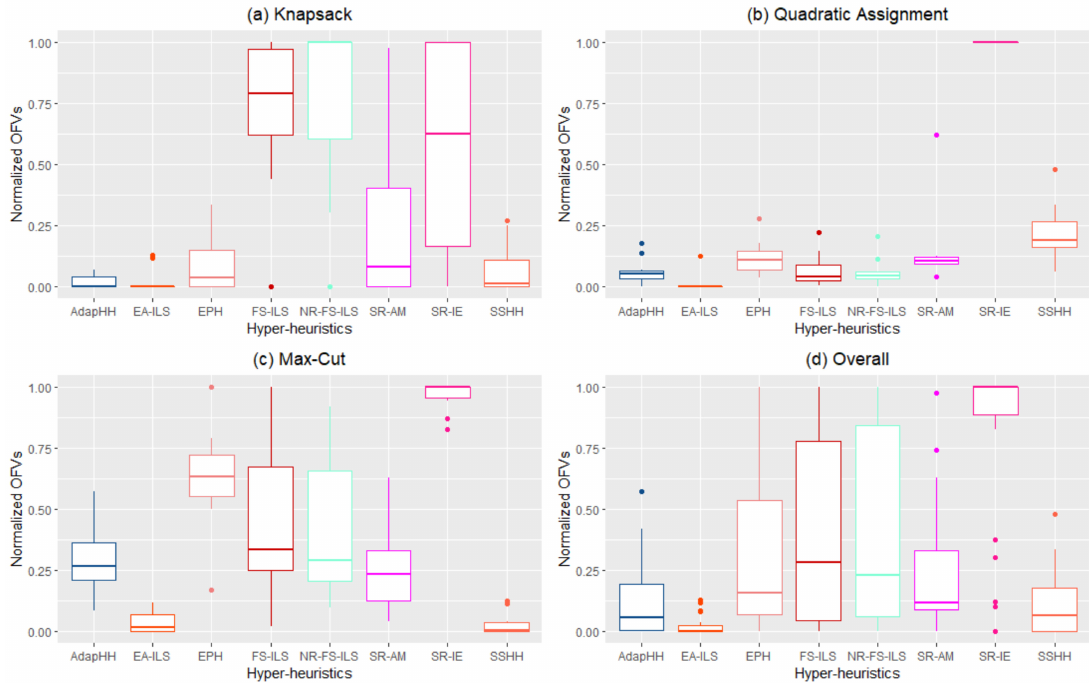
Figure 4. Boxplot visualizations of the median objective function values obtained by hyper-heuristics per domain ( a – c ) and the overall boxplot over all three domains ( d